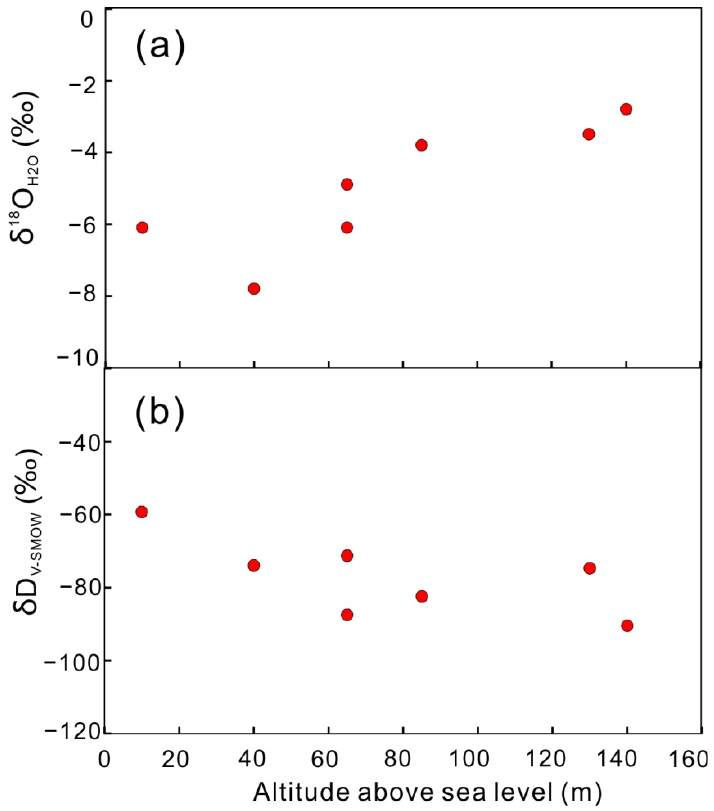
Figure 8. Plot of H ‐ O isotopes vs. altitude. Figure 8. Plot of H-O isotopes vs.